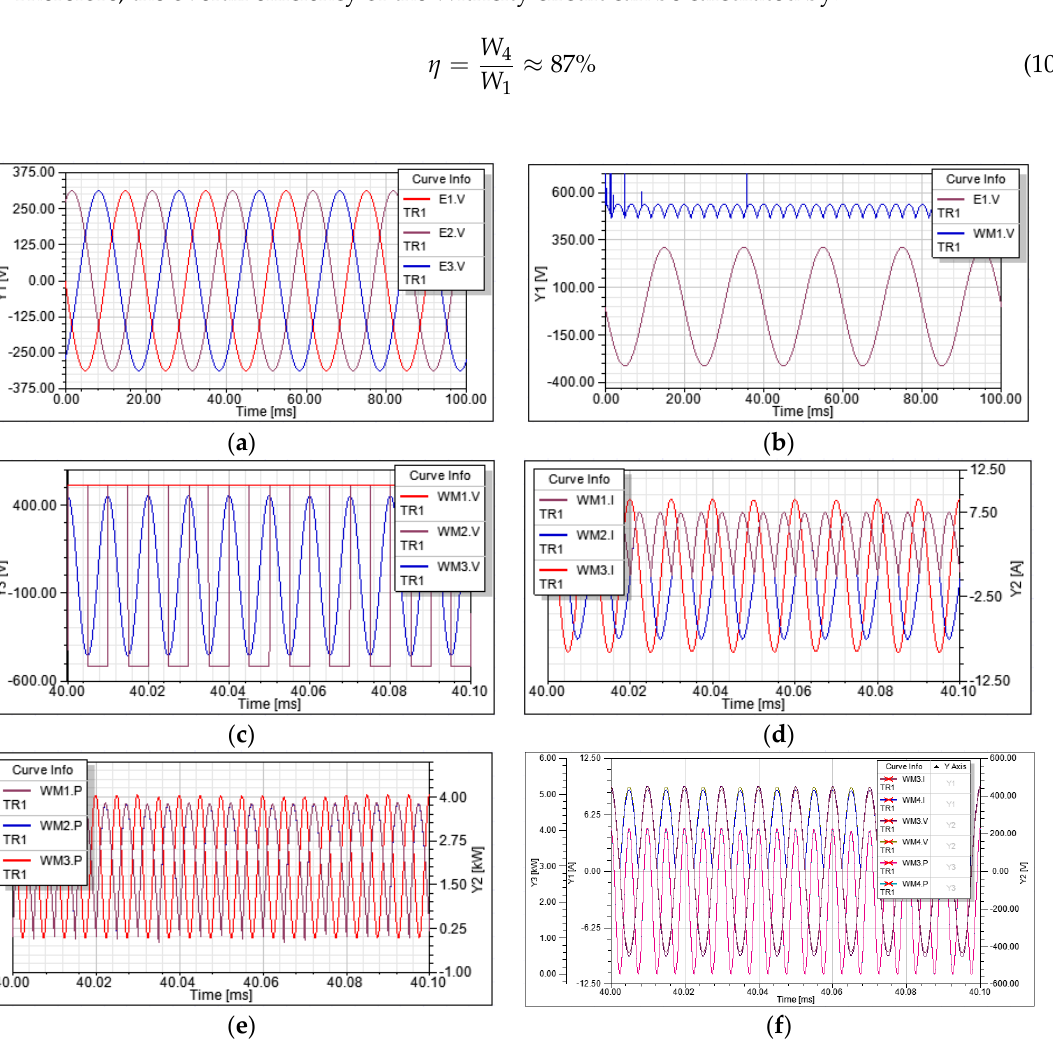
Figure 14. The joint simulation results. ( a ) The three-phase input voltage; ( b ) The three-phase uncontrolled rectifier; ( c ) The voltage of the rectifier terminal, primary side, and secondary side; ( d ) The current of the rectifier terminal, primary side, and secondary side; ( e ) The power of the rectifier terminal, primary side, and secondary side; ( f ) The full-wave bridge rectifier of the secondary side.